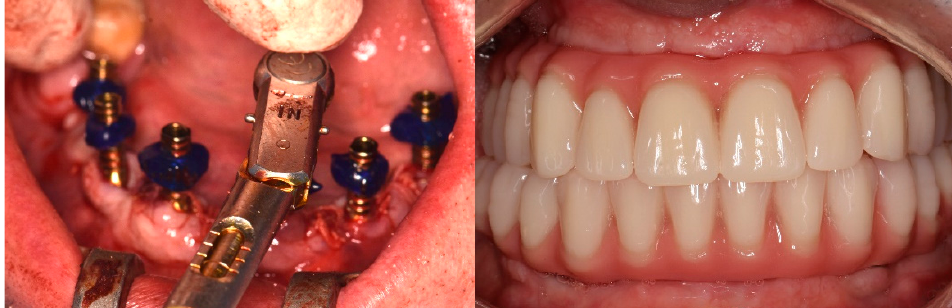
Figure 3. Placement of prosthetic abutments and implant-supported fixed prostheses.